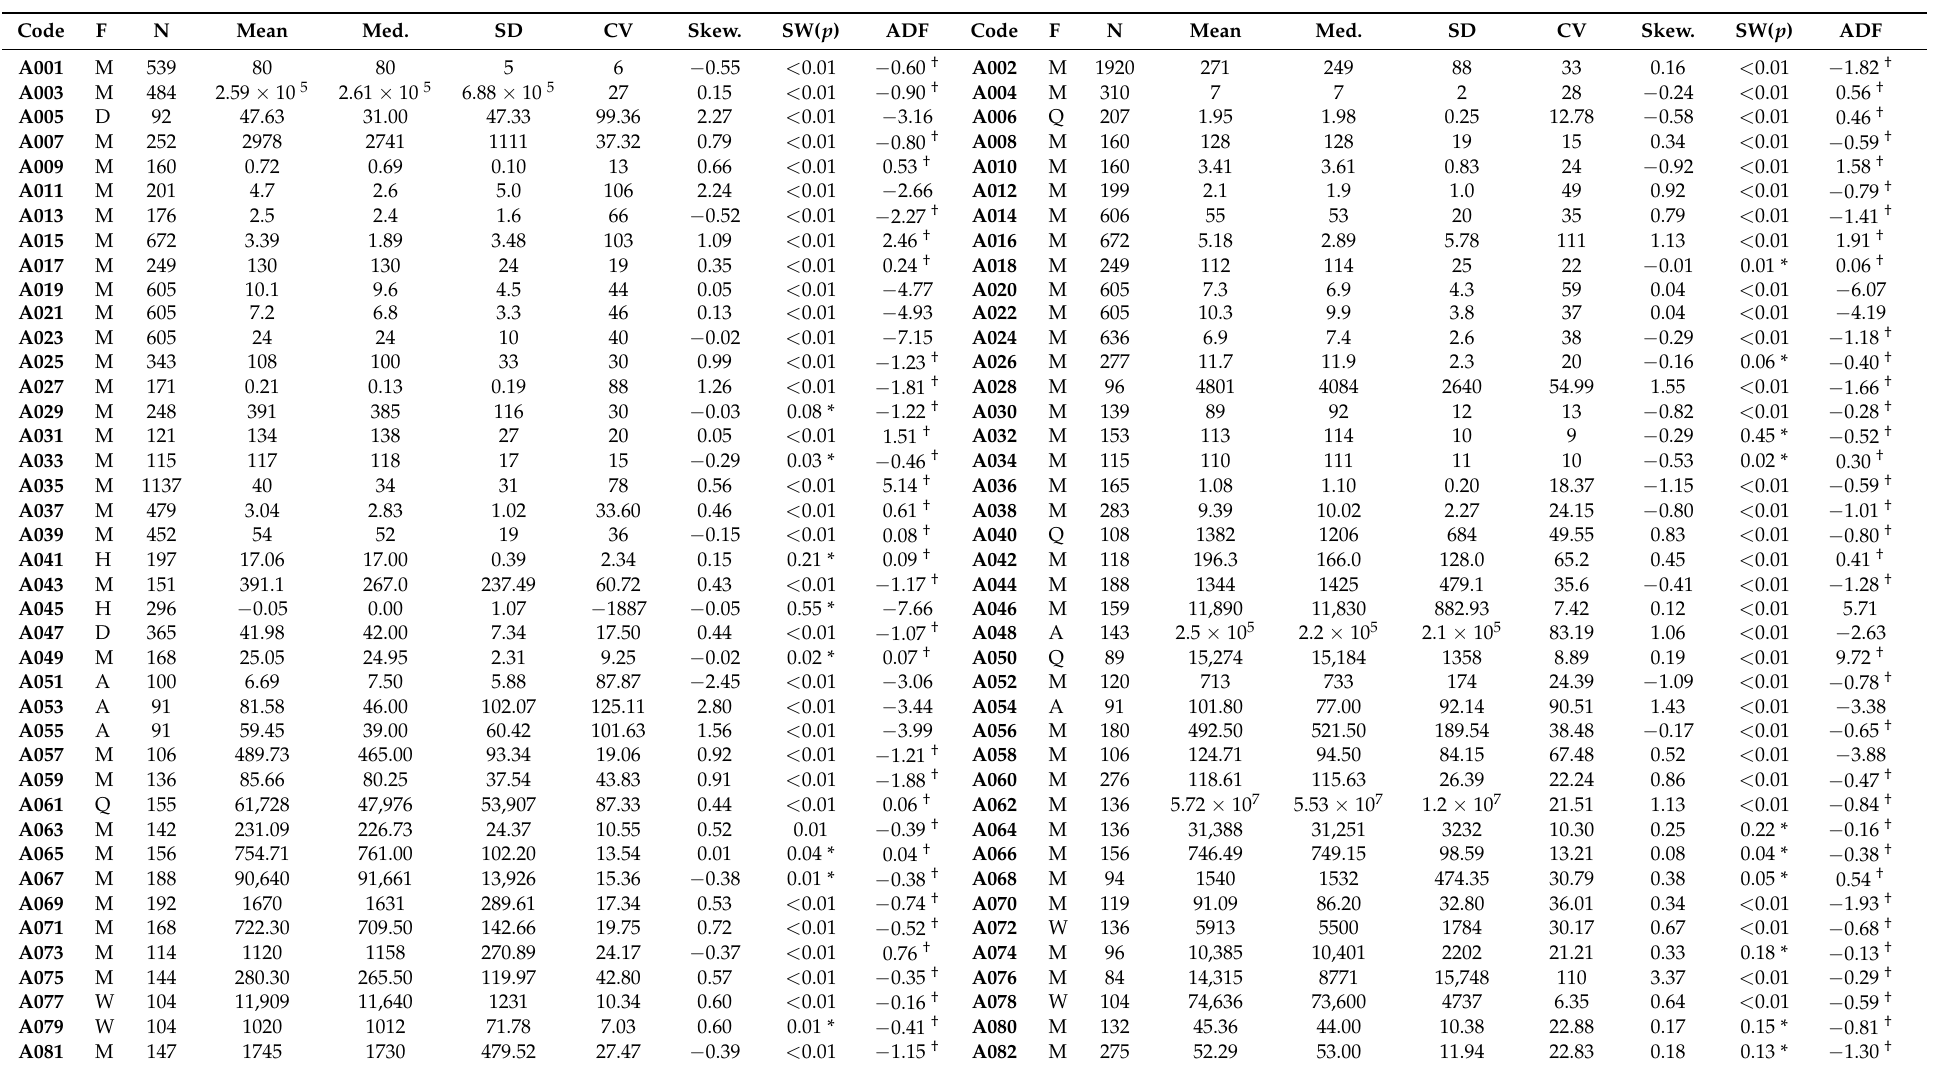
Table A2. Descriptives for the 100 time